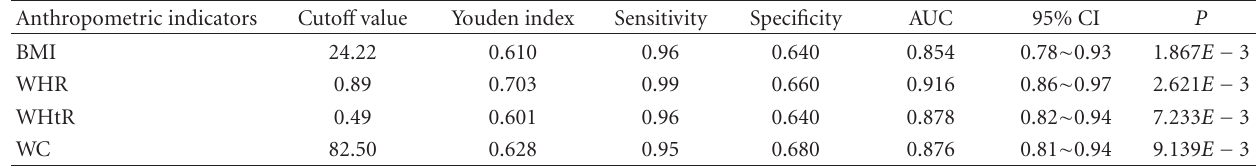
Table 7: Sensitivity, specificity and AUC of cuto ff value of anthropometric indicators in prediction of NAFLD. Anthropometric